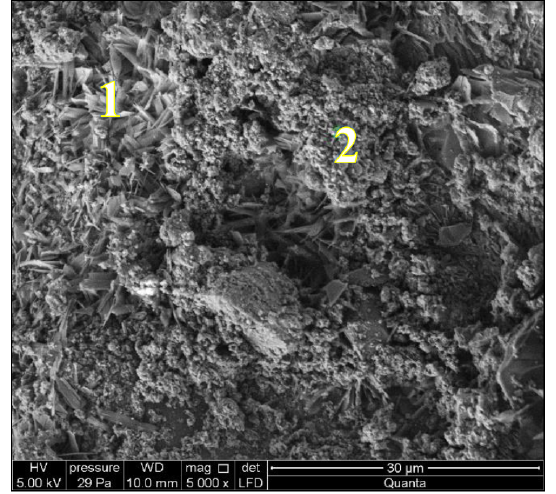
Figure 11: EDS analysis. 2.